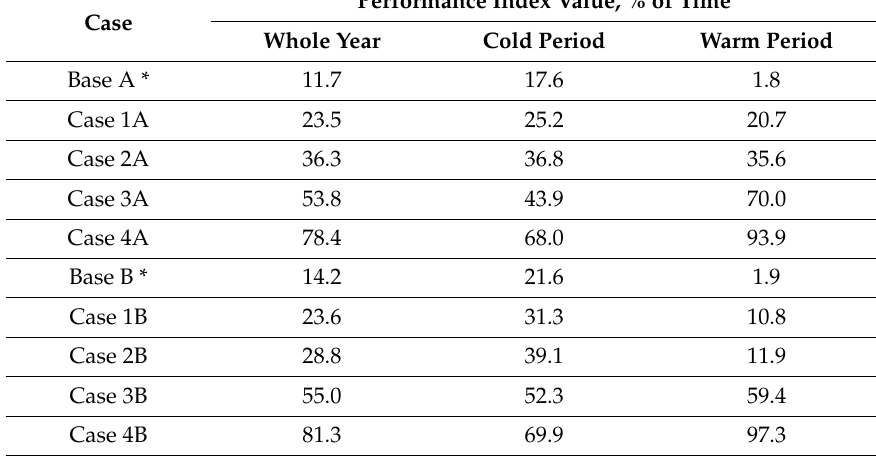
Table 4. The performance index for hourly values of the indoor relative humidity amplitude within ± 5% from RH set point.